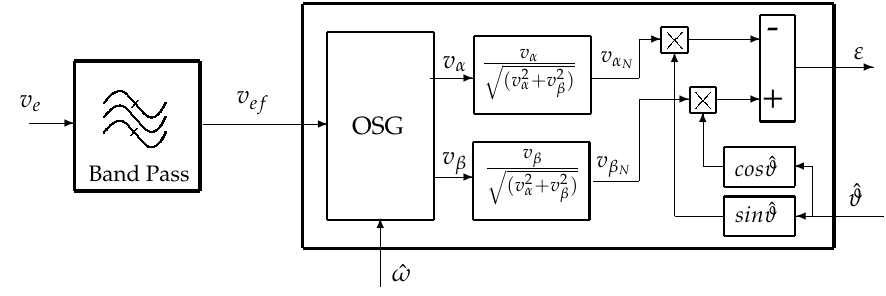
Figure 8. Band Pass and Phase